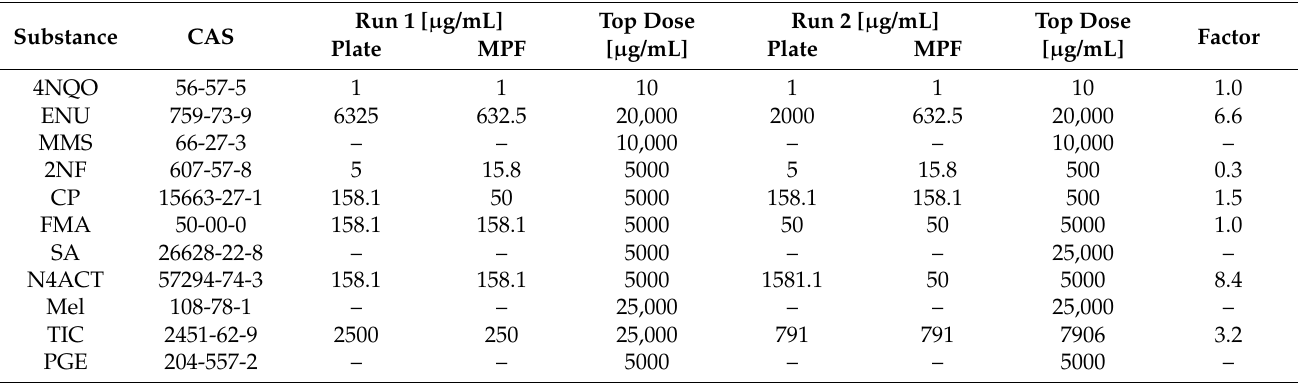
Table A2. Comparison of individual results of two independent test runs in the Ames MPF™ protocol with the standard agar-based Ames test. The concentration in µ g/mL represents the substance in the sample. Each substance was tested in eight concentrations in half logarithmic dilution